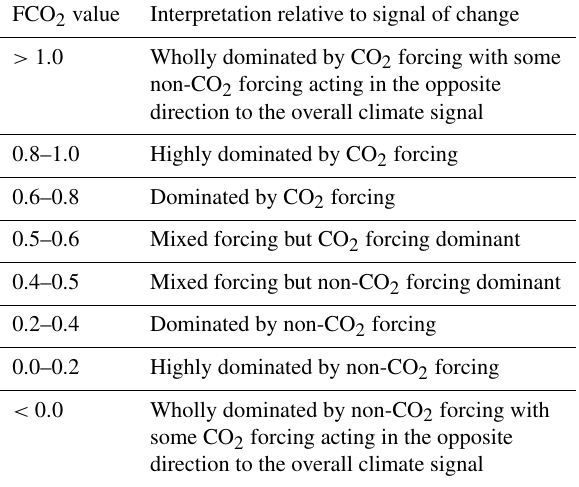
Table 4. Interpretation of FCO 2 values. FCO 2